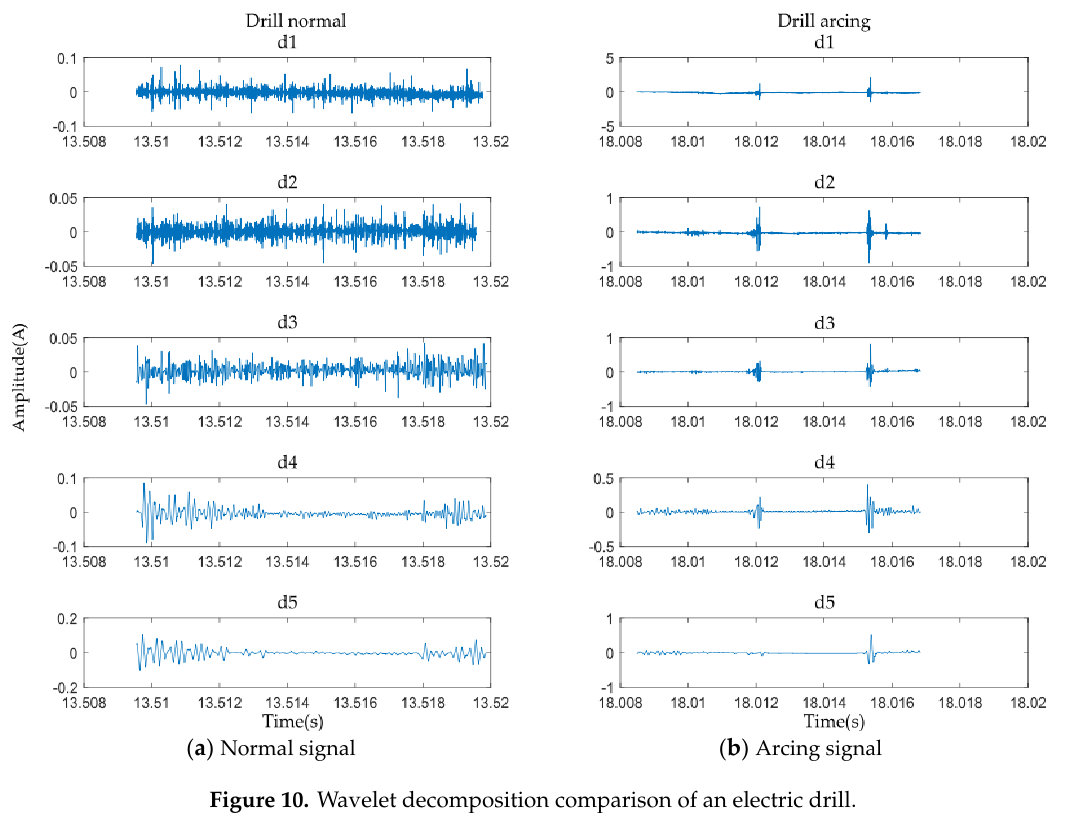
Figure 10. Wavelet decomposition comparison of an electric drill.